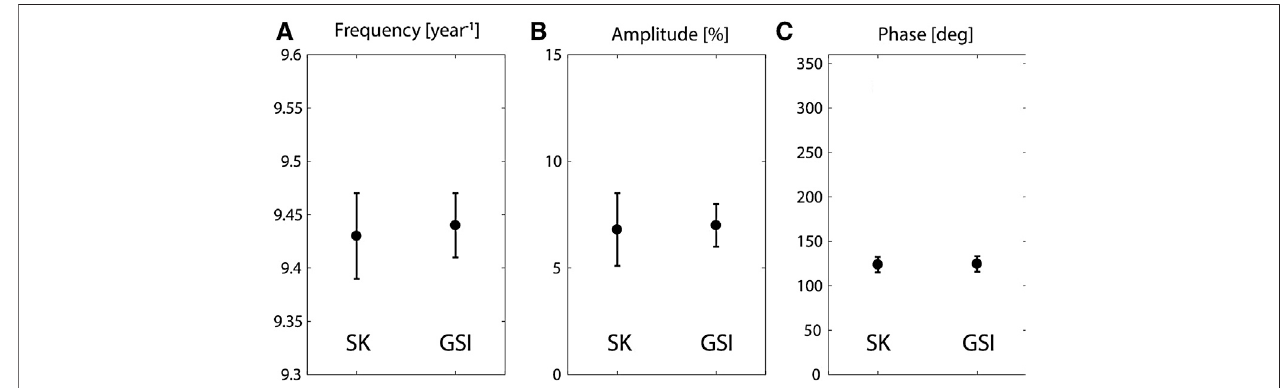
FIGURE 3 | Frequency, amplitude and phase of the 9.43 years − 1 oscillation as it appears in Super-Kamiokande (SK) measurements and in GSI measurements.